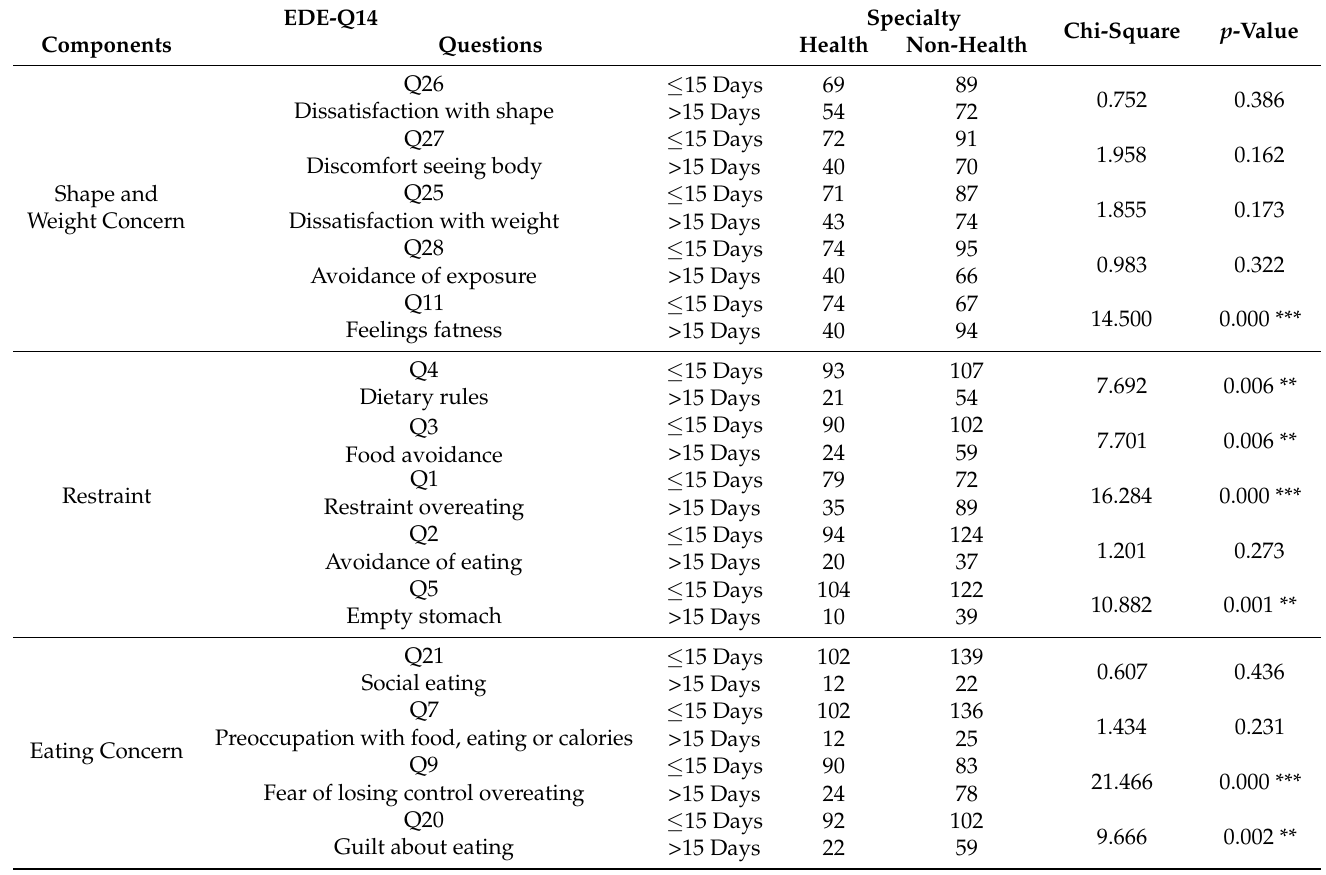
Table 5. Cross-tabulation results of the association between participants specialty and their scores of EDE-Q14 Arabic version (first half split of dataset, n = 275).